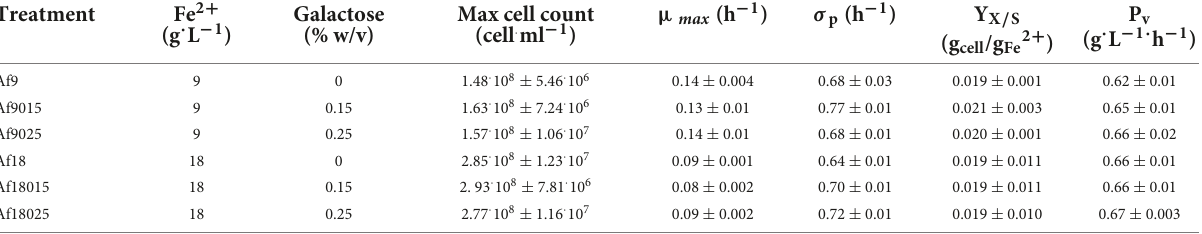
TABLE 1 Kinetic parameters of A. ferrooxidans cultured at different concentrations of iron and galactose. Treatment